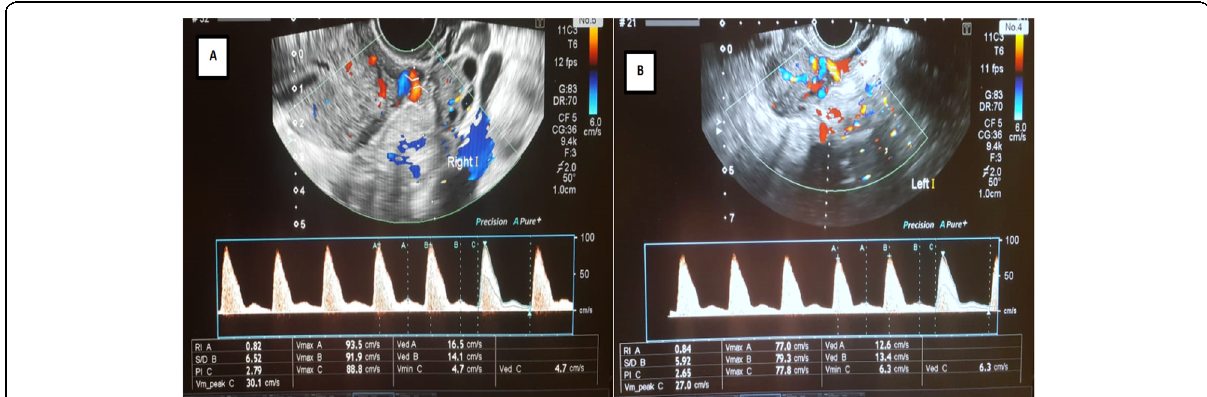
Fig. 7 a , b Transvaginal Doppler ultrasound of both uterine arteries ( a right, b left) of female patient aged 31 years old diagnosed with unexplained infertility shows RI of right and left uterine arteries were 0.82 and 0.84 respectively with mean RI 0.83, S/D ratios of right and left uterine arteries were 6.52 and 5.92 respectively with mean S/D ratio 6.22, and PI of right and left uterine arteries were 2.79 and 2.65 respectively with mean PI